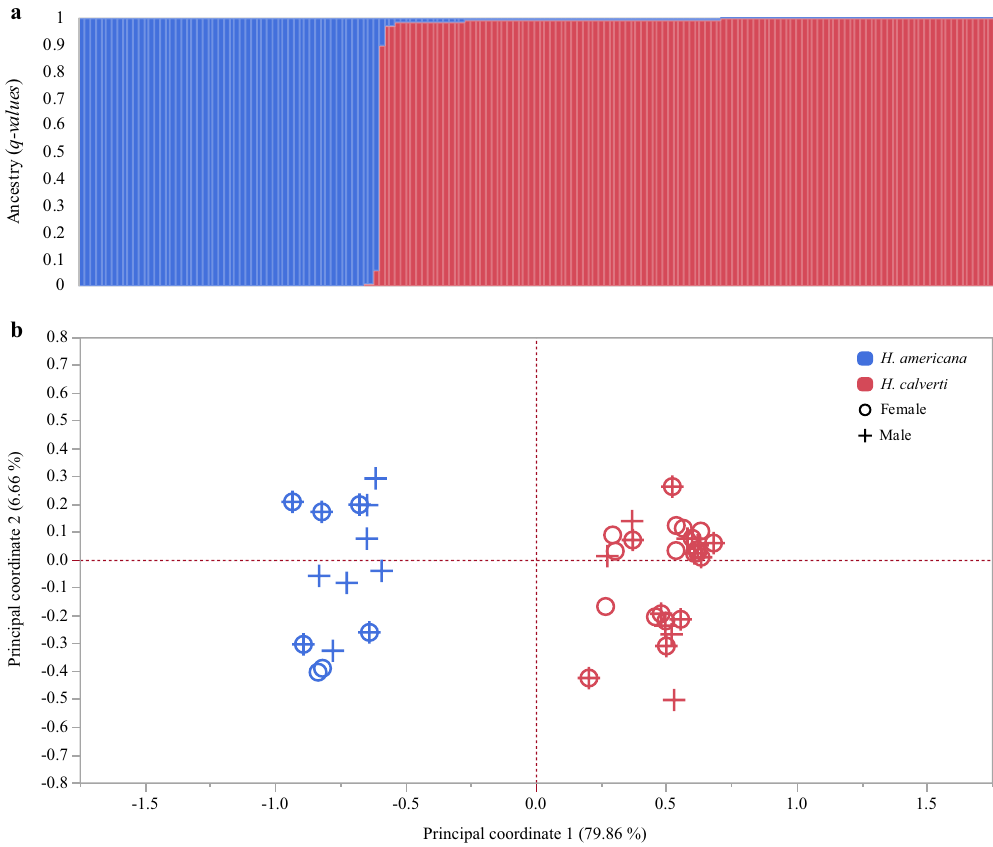
Figure 1. Genetic structure analyses. ( a ) STRU CTU RE assignment analysis for K = 2 from five nuclear microsatellites for sympatric H. calverti and H. americana individuals in Apazapan, Veracruz. In the bar plot, individuals are represented by thin vertical lines, which are partitioned into K shaded segments representing each individual’s estimated membership fraction. ( b ) Principal coordinate analysis (PCoA) for females and males collected in both